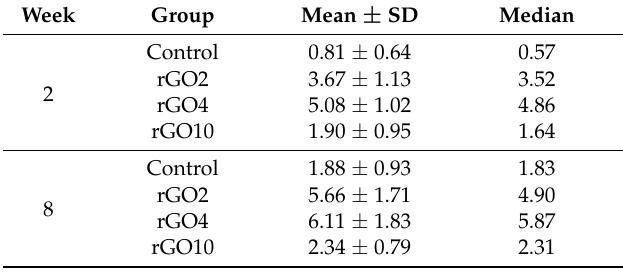
Table 2. New bone area percentages within the areas of interest ( n = 6; %).